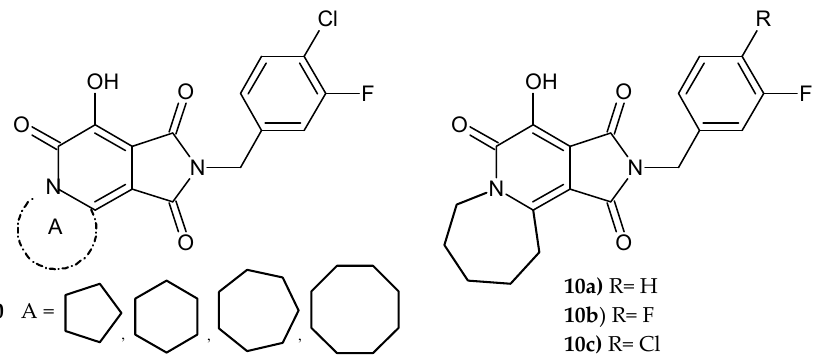
Figure 6. Tricyclic compounds containing pyrrolo[3,4- c ]pyridine scaffold 10 as HIV-1 integrase inhibitors and the most active compounds 10a – c .